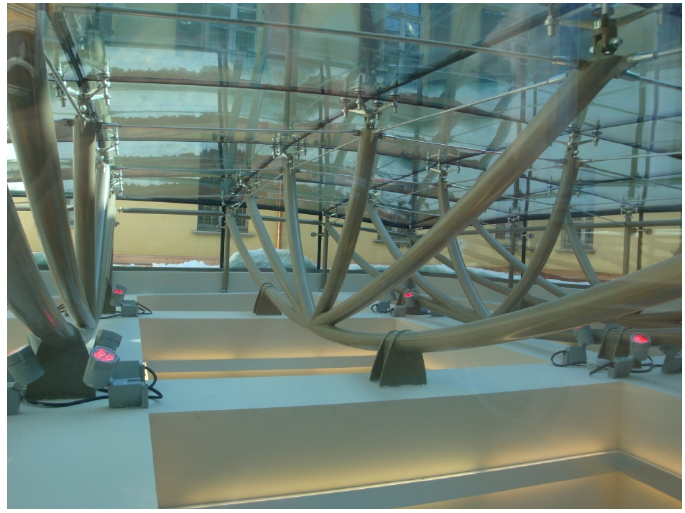
Figure 3: Internal view.